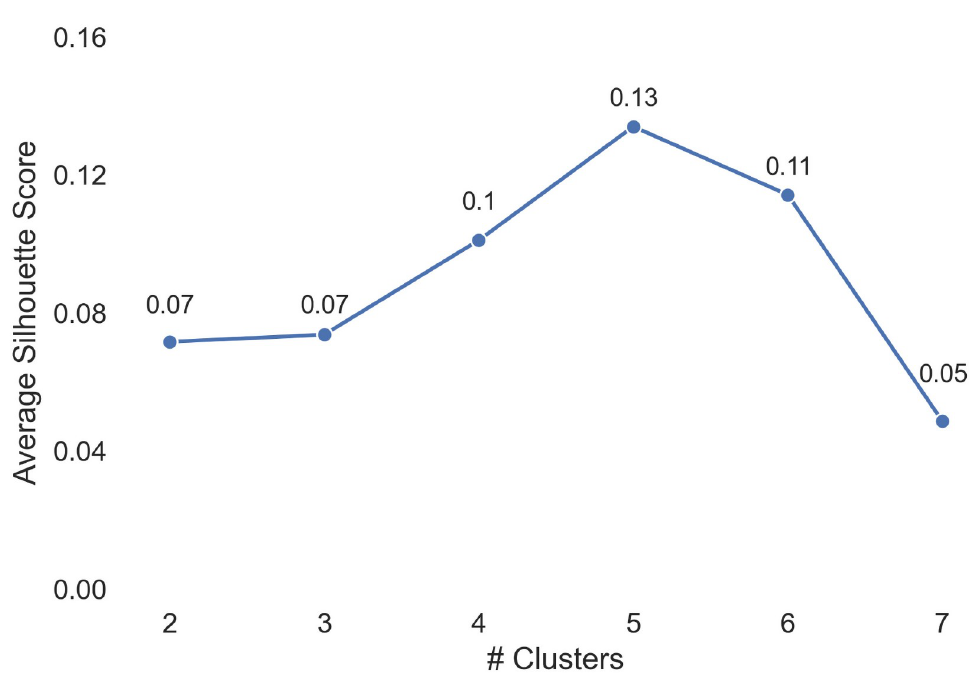
Fig 4. Plot of average silhouette score vs. number of clusters in Gaussian Mixture models.